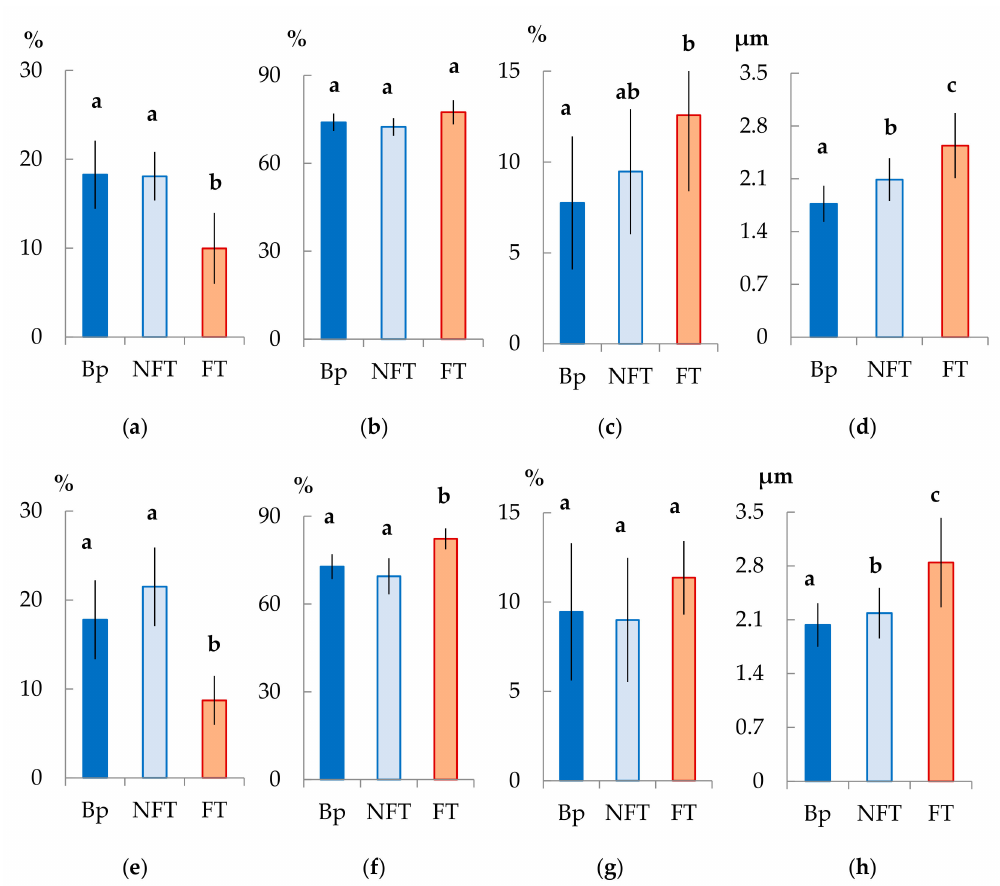
Figure 4. Anatomical parameters of B. pendula var. pendula (Bp) mature xylem, non-figured (NFT), and figured (FT) B. pendula var. carelica mature xylem. Samples were collected on 25 June 2019 ( a – d ) and 26 June 2020 ( e – h ). Proportion (%) of vessels ( a , e ), fibrous tracheids ( b , f ), radial and axial parenchyma ( c , g ), and cell wall thickness ( µ m) of fibrous tracheids ( d , h ) in the mature xylem of the studied trees are shown. Different letters indicate significant differences at p -value < 0.05. Bars are means of n experimental runs ± SD according to Mann–Whitney U-test n = 9.